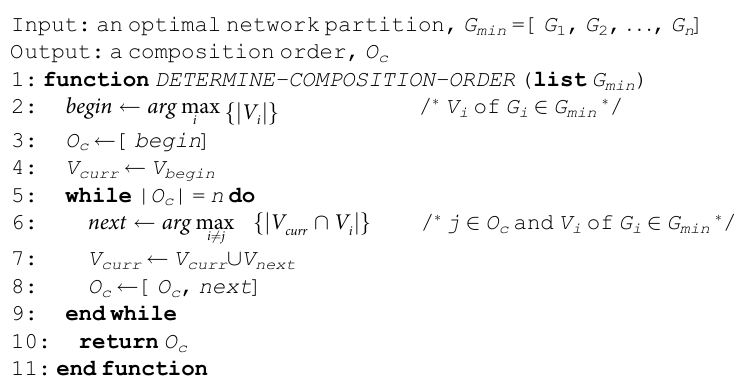
Algorithm 2 Pseudocode for determining an order of composing local steady states